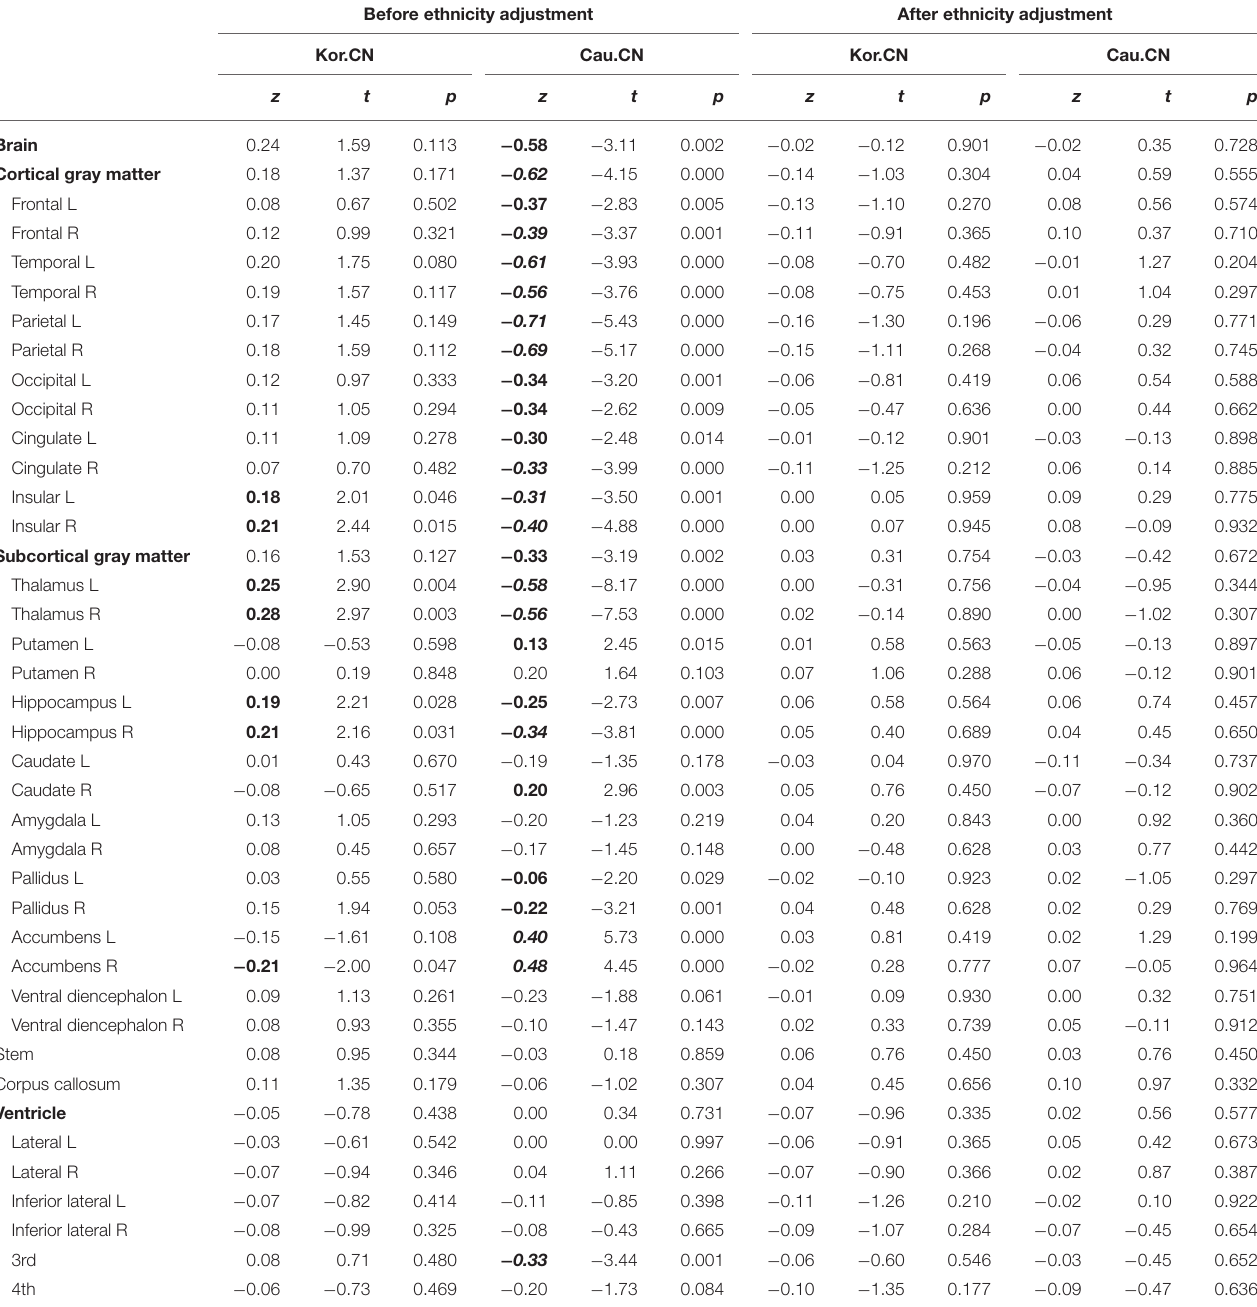
TABLE 5 | Z-scores and the differences between the observed volumes and the predicted volumes. Before ethnicity adjustment After ethnicity adjustment Kor.CN Cau.CN Kor.CN